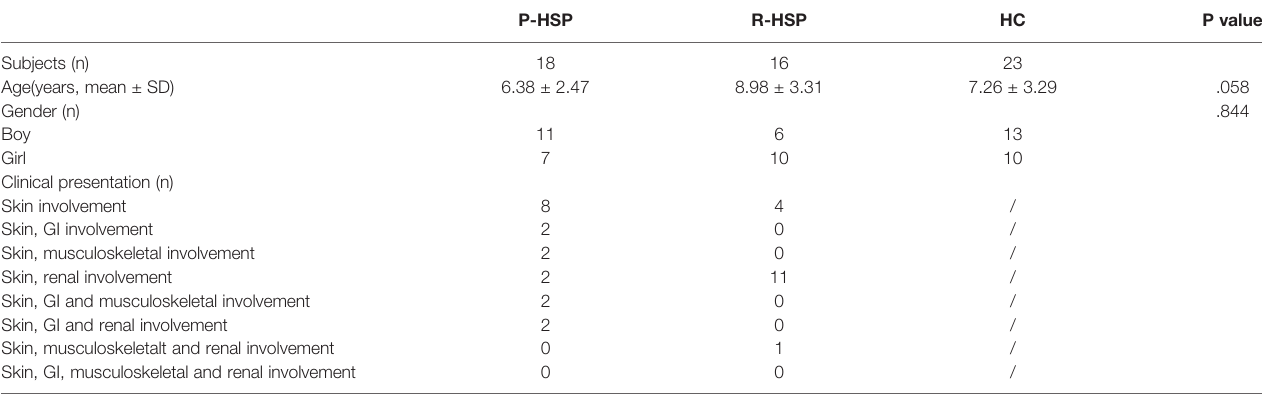
TABLE 1 | Characteristics of study